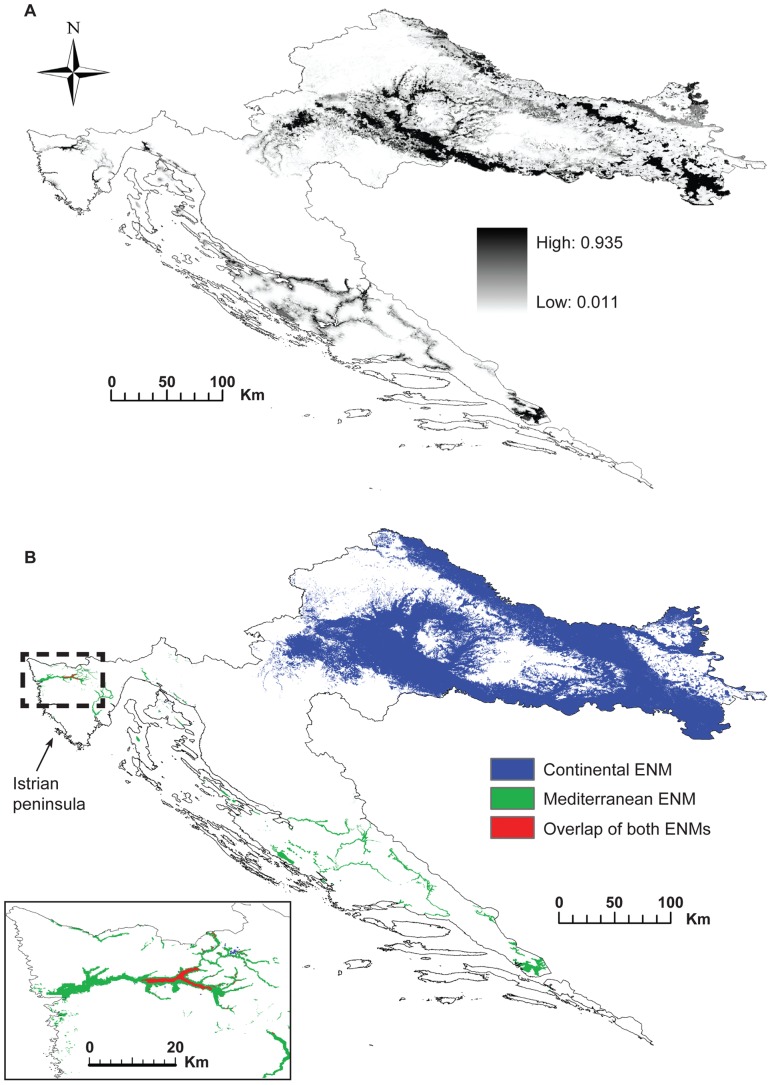
Predicted Maxent Ecological niche models (ENMs) for Fraxinus angustifolia.A) Overall ENM. Colour levels of shading from white (unsuitable habitat) to black (highest suitability) represent the continuous species' probability distribution after thresholding. B) Overlay of the two independently predicted regional ENMs to identify areas of environmental overlap (highlighted by the enlarged box). Minimum training presence thresholds: Continental = 0.012, Mediterranean = 0.044.